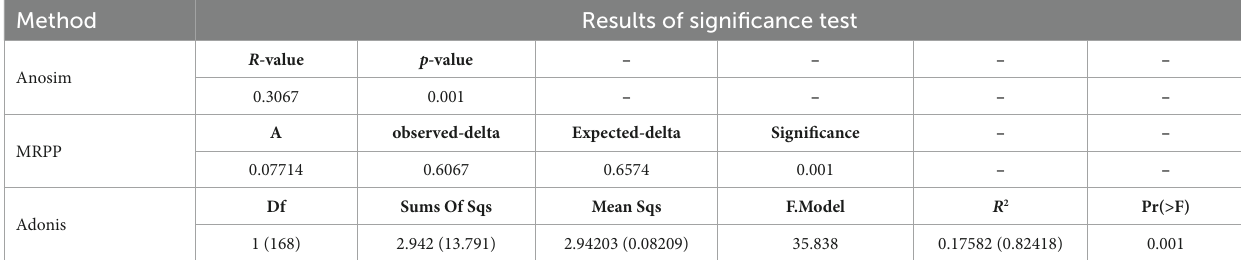
TABLE 2 Differences significance test of community structure between dual-purpose and egg type